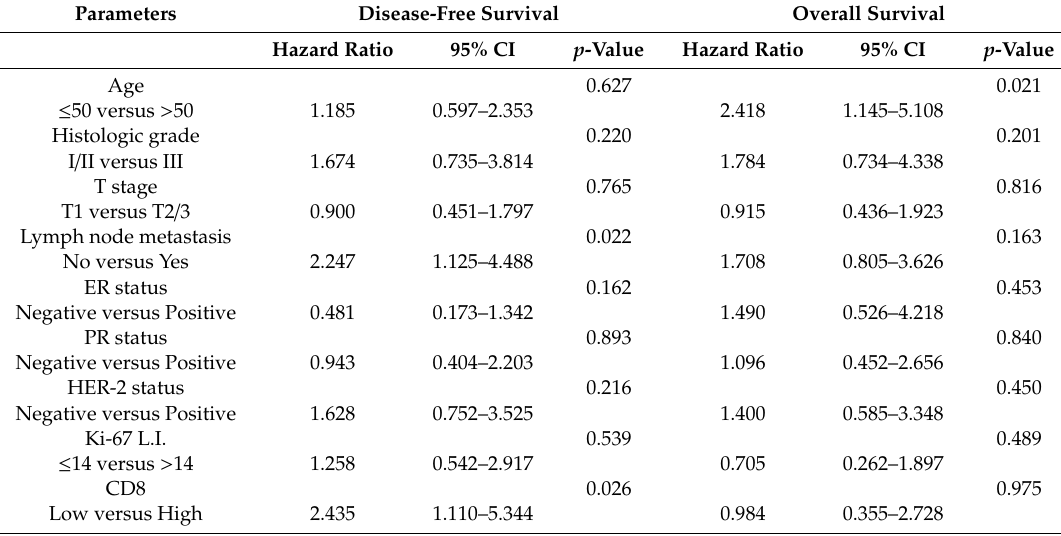
Figure 3. Impact of immune cell subtype-related protein expression on patient prognosis (disease-free survival, DFS). ( A ) High-level CD8 expression was associated with shorter DFS ( p = 0.003). ( B – F ) High-level CD8 expression was associated with shorter DFS in luminal B type ( p = 0.004), ER-positive ( p = 0.005), PR-negative ( p = 0.022), HER-2-positive ( p = 0.001), and high Ki-67 L.I. (Ki-67 L.I.> 14; p = 0.005) breast cancer. L.I.: labeling index. Table 6. Multivariate analysis of the impact of prognostic factors of breast cancers on disease-free survival and overall Table 5. Univariate analysis of the impact of infiltrating immune cell subtype-related protein expression in breast cancers on disease-free survival and overall survival using the log-rank test.